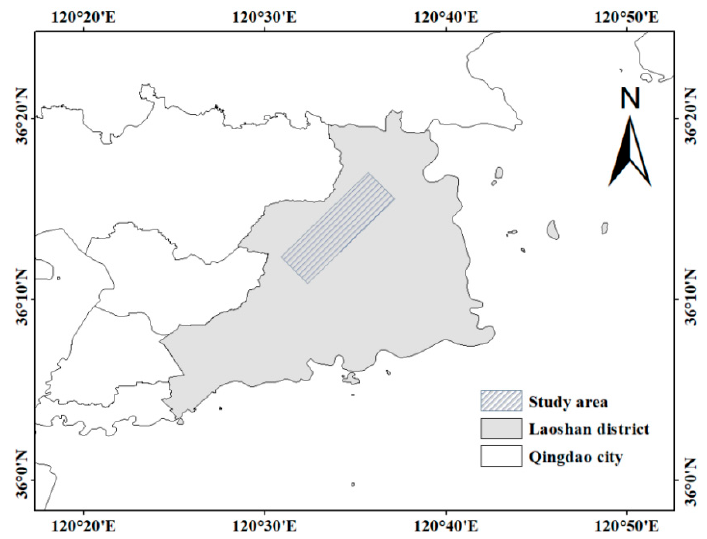
Figure 1. Location of the study area.